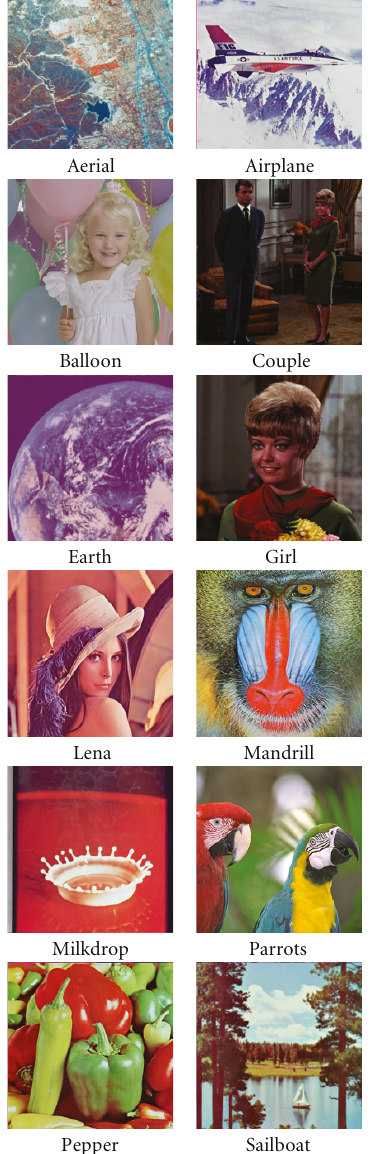
Figure 9: Watermarked images